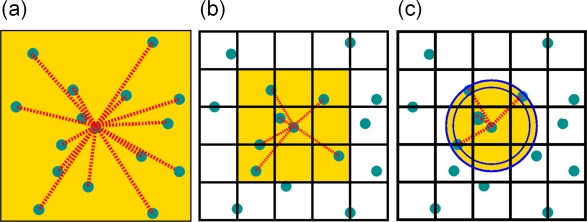
MD Optimization schemes for the search of potentially interacting particles. (a) The least efficient all particle “brute force” approach with run time
O(N2) (b) The linked-cell algorithm which reduces the search effort to
O(N). (c) The linked-cell algorithm combined with neighbor lists which further reduces the search effort by using a list of potentially interacting neighbor particles which can be used for several timesteps before it has to be updated. In this 2D representation, the radius of the larger circle is rcut + rskin and the inner circle, which contains actually interacting particles, has radius rcut.